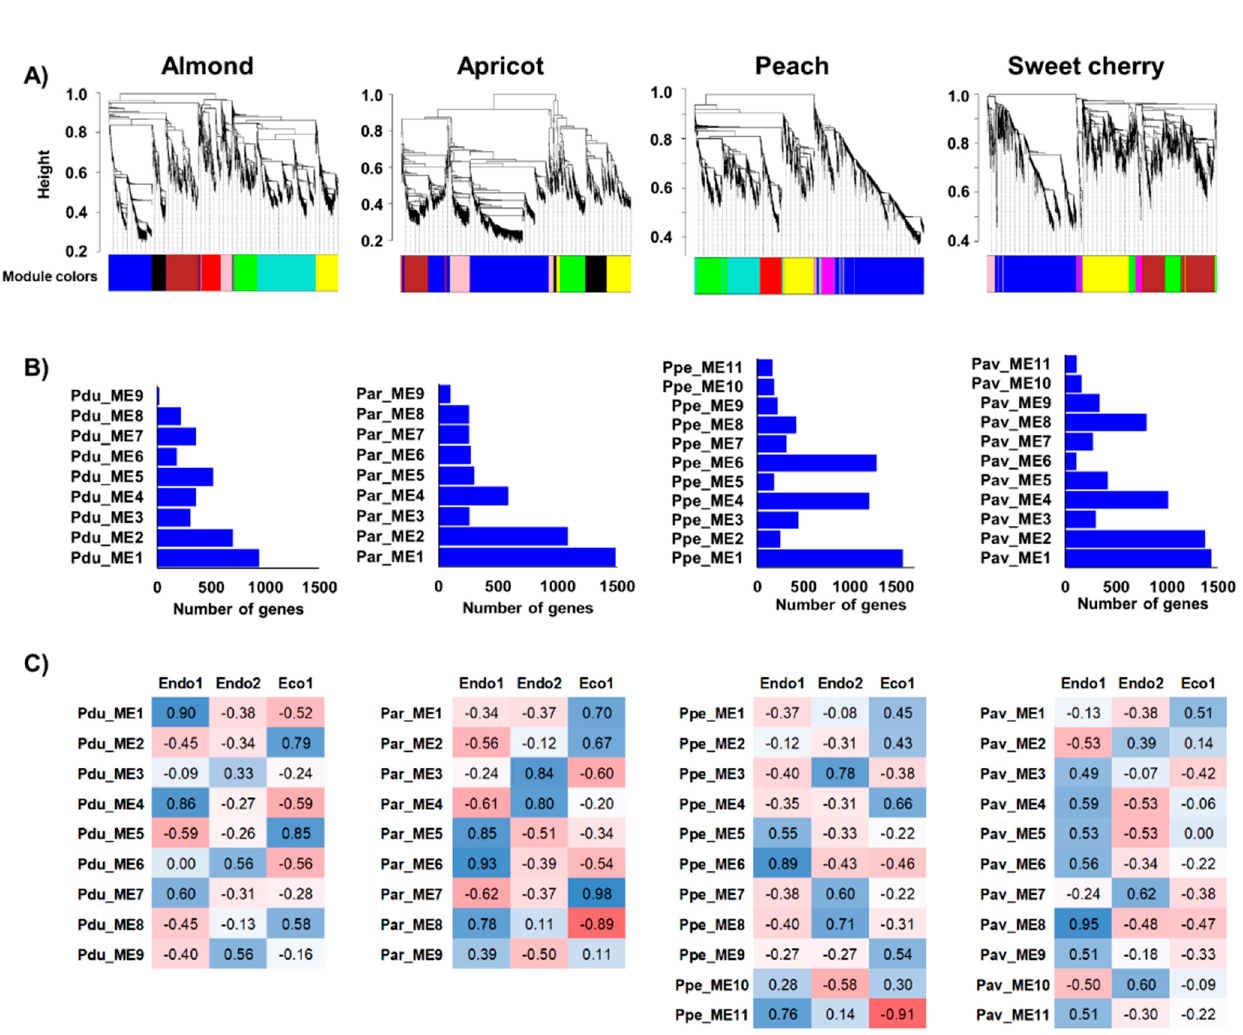
Figure 3. Co-expression networks constructed in almond, apricot, peach, and sweet cherry. ( A ) Dendrograms of gene clustering based on RNAseq data. ( B ) Number of genes in each module. ( C ) Correlation ( p − values) between modules and dormancy stages (red and blue colorations indicate a negative and positive correlation, respectively).